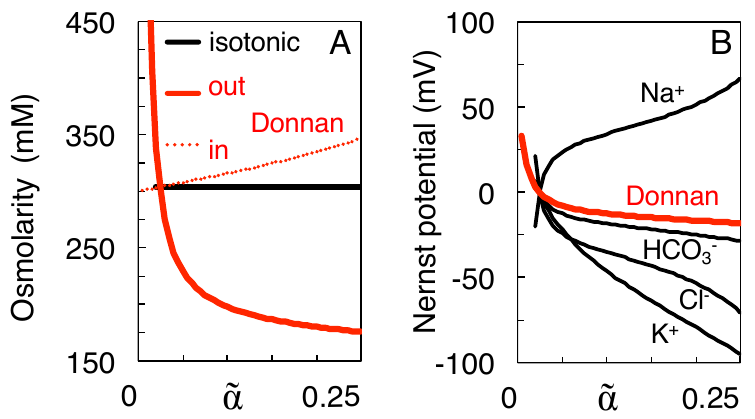
Figure 2. Comparison of the isotonic mixing path (black curves) and the Donnan equilib- rium at each intermediate volume (red). ( A ) Extra- and intracellular total solute concentration. ( B ) Transmembrane Nernst potential. For the Donnan equilibria, the four Nernst potentials coincide at their common Donnan potential. In this and the following figures, mixing starts from the physio- logical concentrations of Table 1 (at ˜ α = α = 0.25), and the concomitant shrinkage of extracellular space is monitored by variable ˜ α on the horizontal